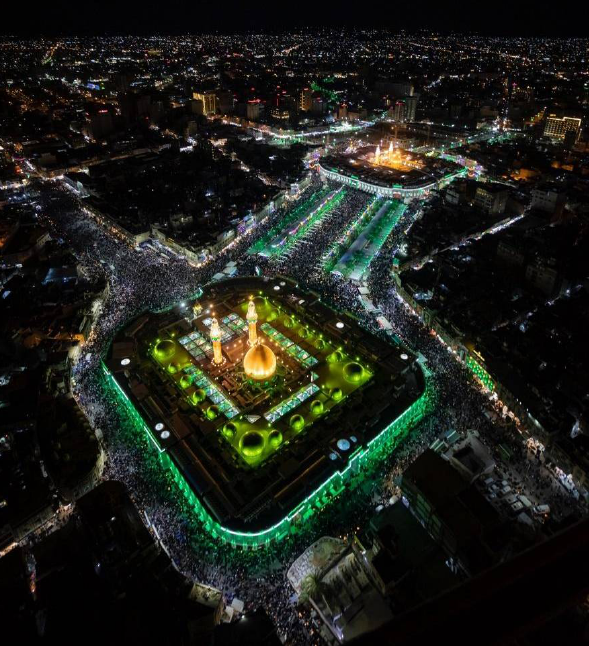
Figure 7. Aerial view of Bayn al-Haramayn pedestrian during Ashura at night. Source: “Photo Gallery”, ImamHussain.org—(n.d.) https://pic.imamhussain.org/gallery/show/16175 accessed on 1 October 2021.